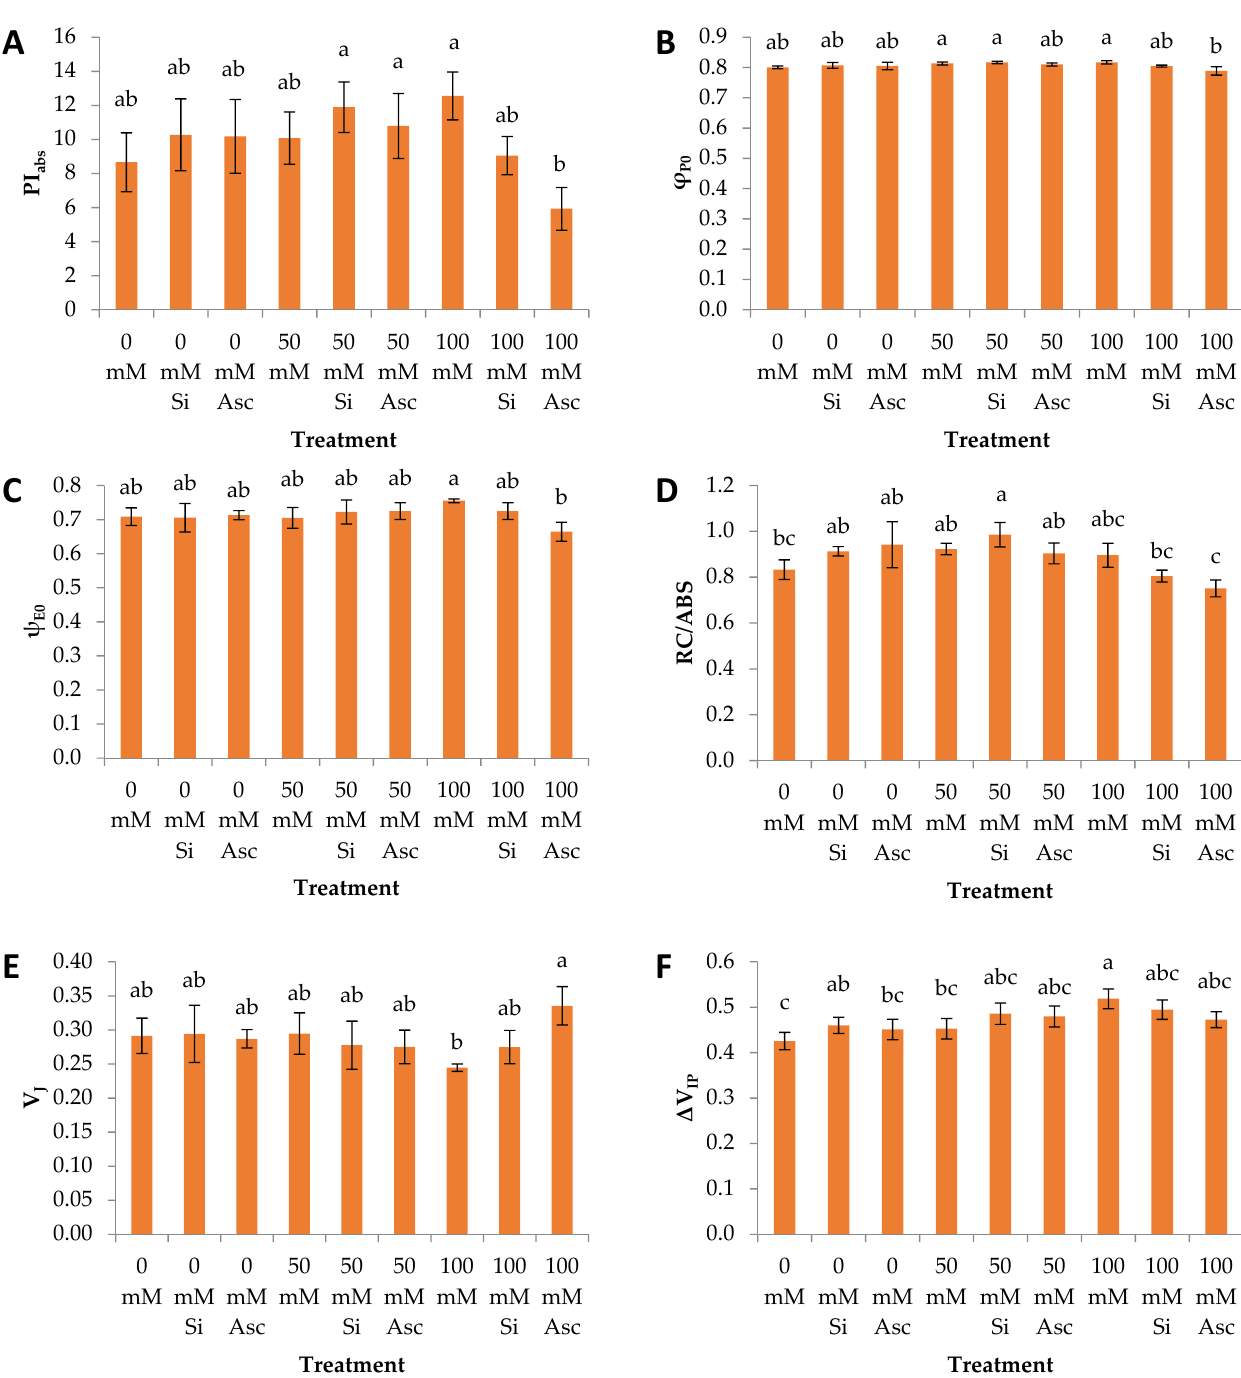
Figure 2. ( A ) PI abs , ( B ) ϕ P0 , ( C ) ψ E0 , ( D ) RC/ABS, ( E ) V J , and ( F ) ∆ V IP of watermelon transplants irrigated with nutrient solution of different NaCl concentration and sprayed with two biostimulants. Within a bar, average values (n = 5) followed by different letters are significantly different (a < 0.05).